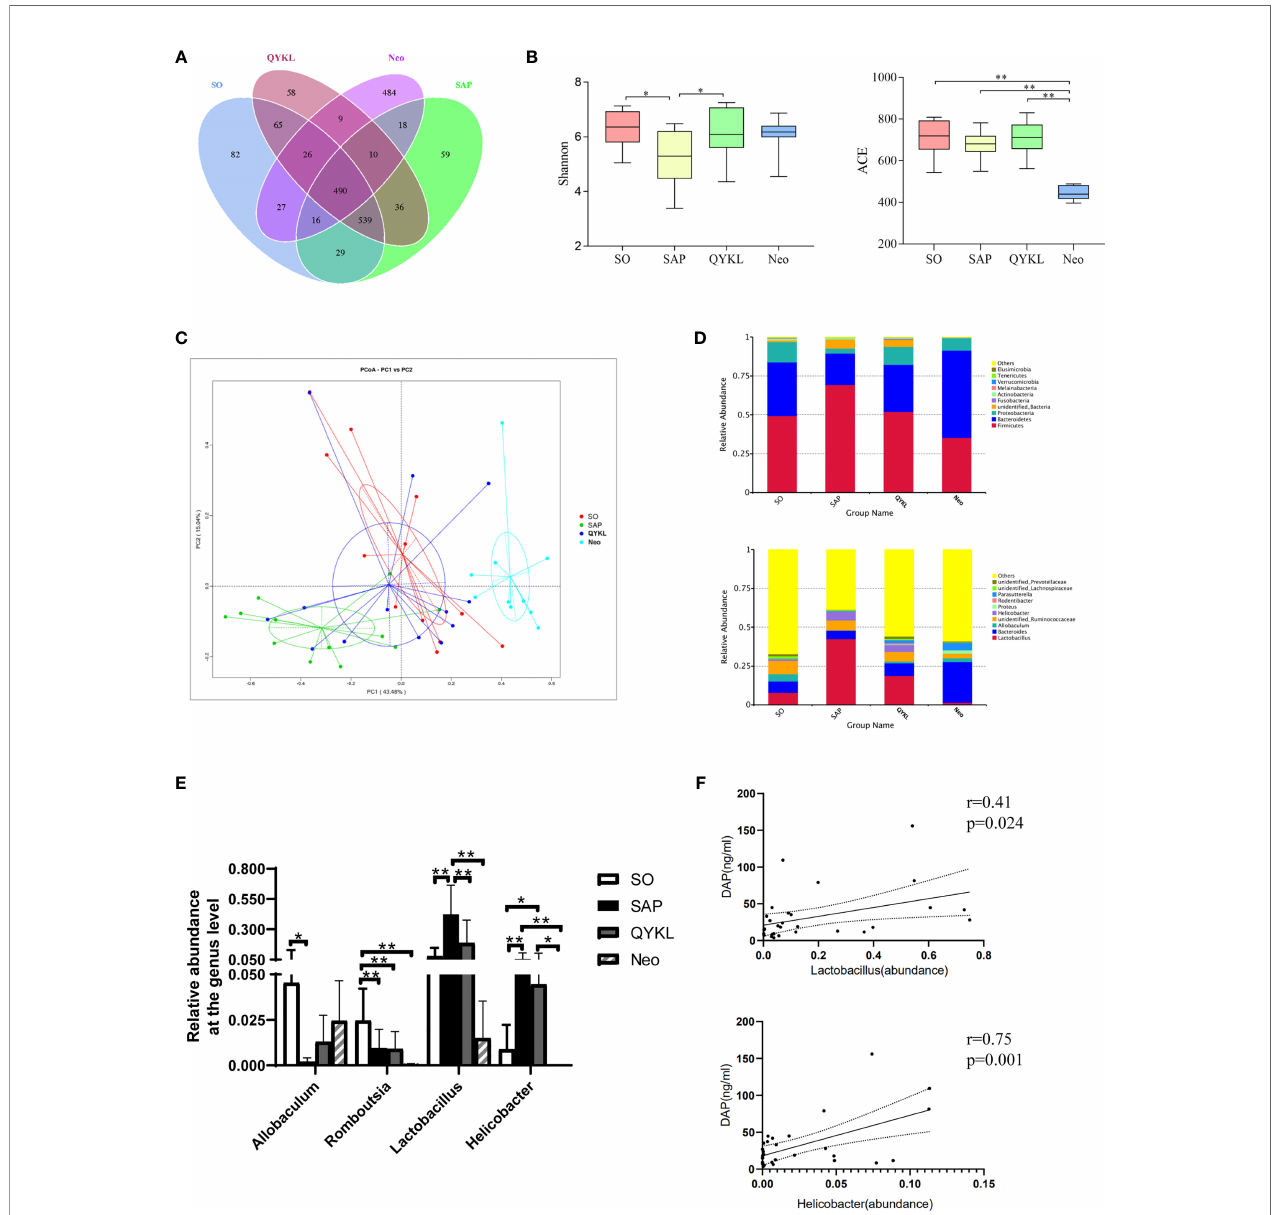
FIGURE 4 | Differences in the gut microbiota components among the four groups. (A) OTU numbers among the four groups; (B) Alpha diversity re fl ected by the Shannon index ( p = 0.04) and ACE index ( p < 0.01); (C) Beta diversity re fl ected by principal coordinate analysis (PCoA, Adonis analysis, p = 0.003); (D) Relative abundance of the gut microbiota at the phylum and genus levels; (E) Four bacteria that changed signi fi cantly in at least two groups. (F) Pearson correlation analyses between serum DAP level and the abundance of Lactobacillus and Helicobacter (n = 28). Tukey test for Panel B , PCoA for Panel C , and ANOVA test for Panel E (n = 12 in SO group, n = 12 in SAP group, n = 13 in QYKL group, n = 10 in Neo group); * p < 0.5, ** p <